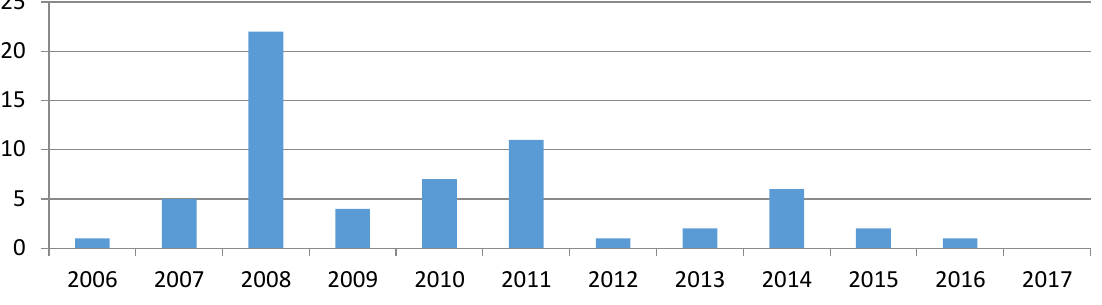
Figure 3. Frequency of overreactions: case of the PFTS index for the period 2006–2017 (annual